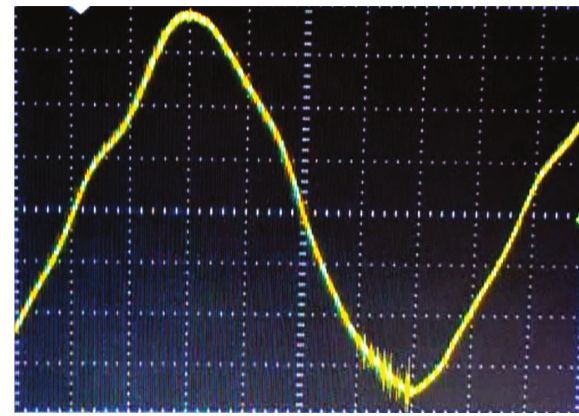
Figure 14: Typical waveform representation on the oscilloscope depicting air corona discharges on sinusoidal base.